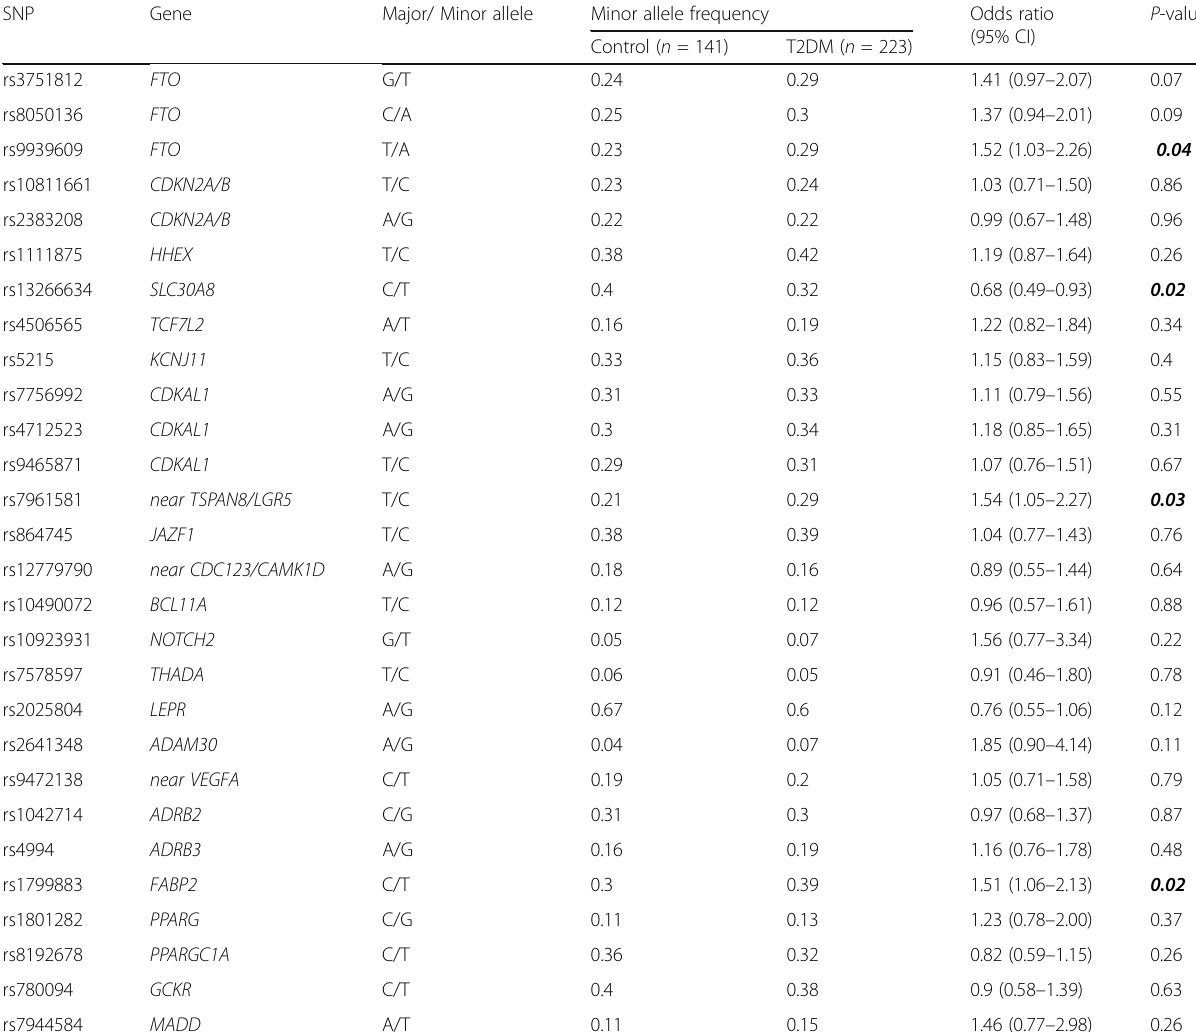
Table 4 Association of candidate SNP loci with type 2 diabetes in the age-matched Kazakh study